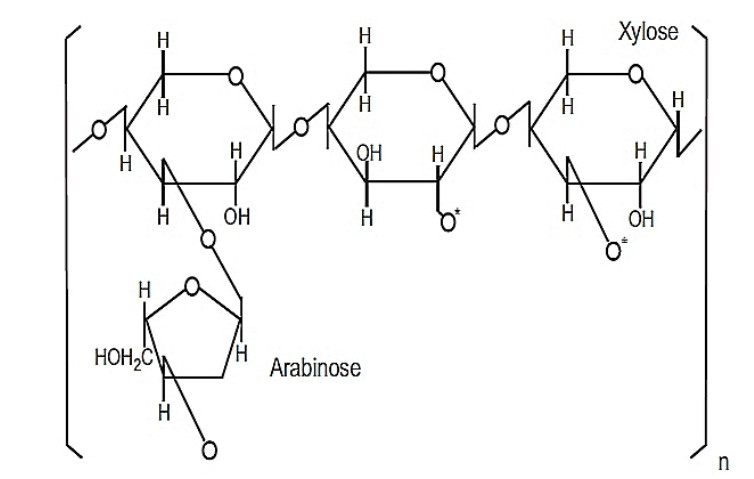
Figure 3. Chemical structure of MGN-3/Biobran. Reprinted from Wheat and Rice in Disease Prevention and Health, 1st ed., M. H. Ghoneum, Chapter 31—Apoptosis and arabinoxylan rice bran, pp. 401–408, Copyright 2014, with permission from